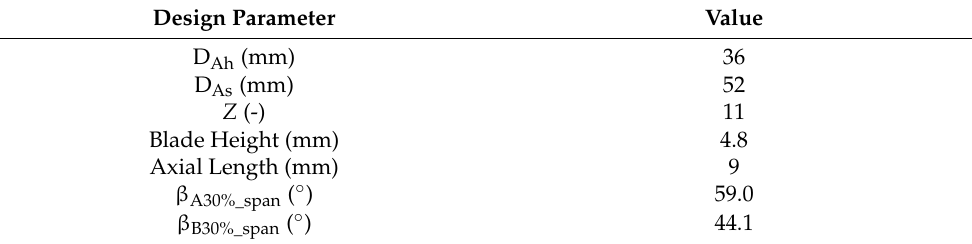
Table 1. Final fan design parameters.